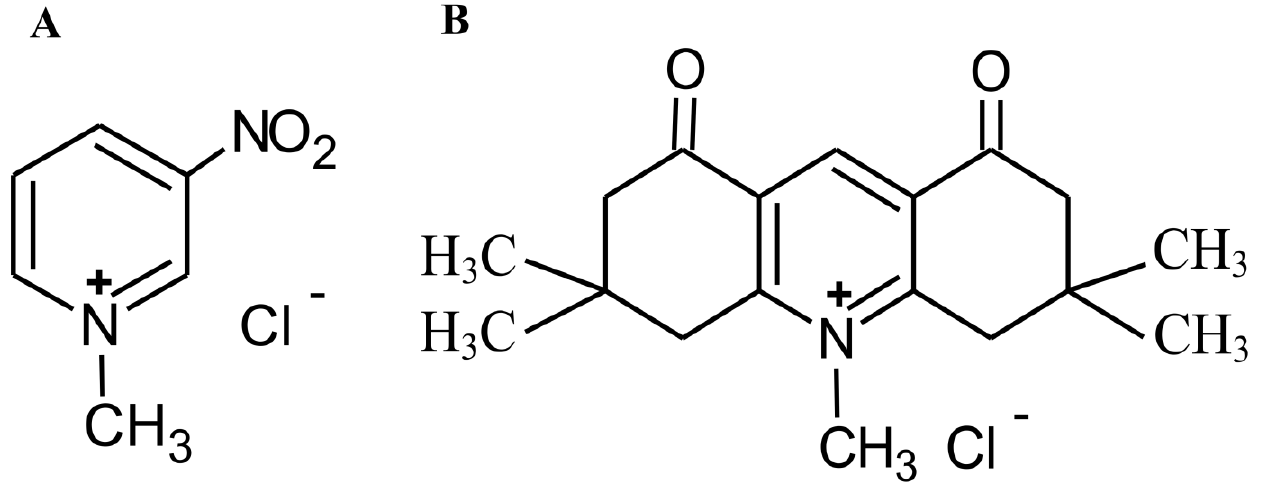
Figure 1. Structure of MNP ( A ) and MDION ( B ).